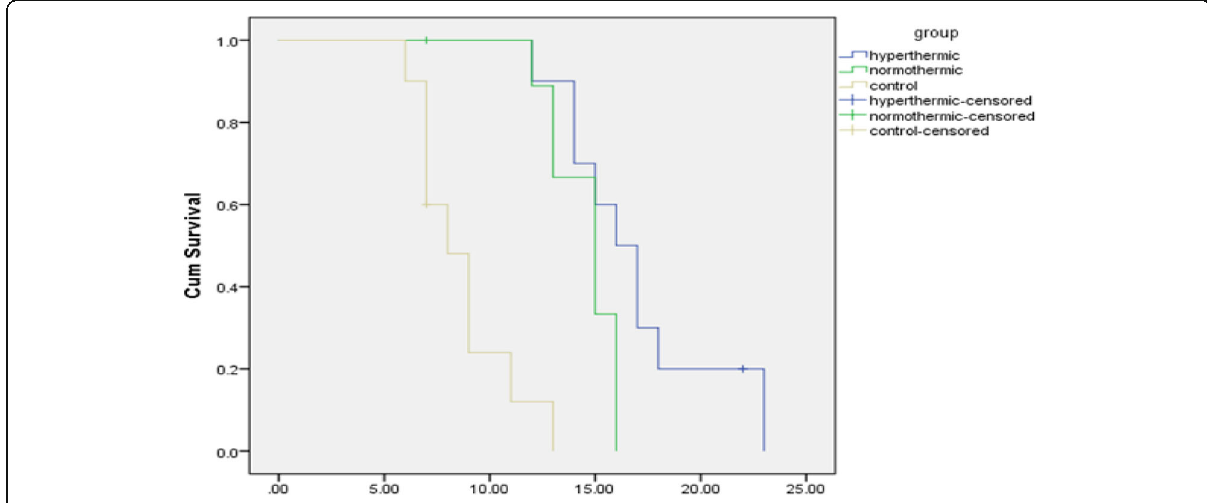
Fig. 4 Survival between groups at the end of our